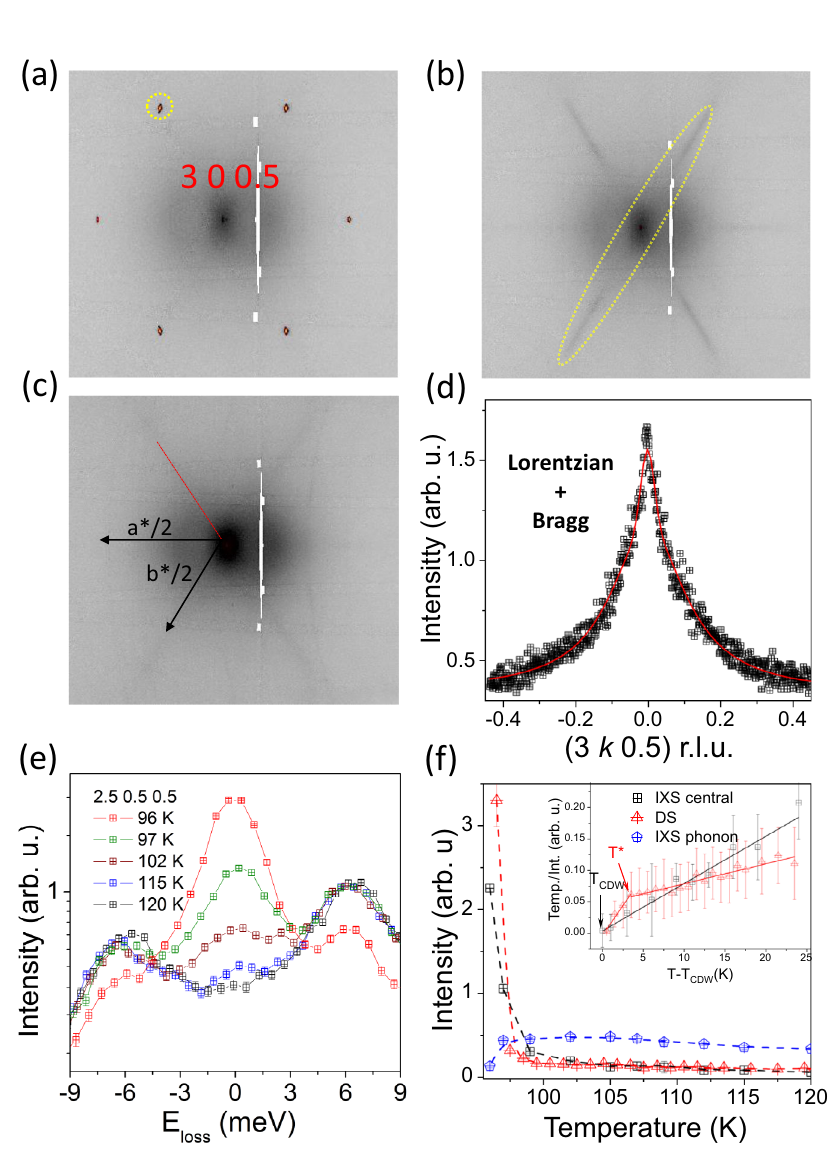
Fig.3|TemperaturedependenceofthediffusescatteringandIXScentralpeak. a 90 K, b 100 K and c 150 K around the (3 0 0.5) cut. The sketch in c shows the reciprocallatticevectorsandtheIXSscandirectionthroughtheCDW,asindicated in the red line. d Pro fi le of the diffuse scattering at 120 K and its fi tting to a sum of BraggandLorentzianpro fi les. e TemperaturedependenceoftheIXSspectraatthe (2.5 0.5 0.5) reciprocal lattice vector, highlighting the enhancement of the elastic